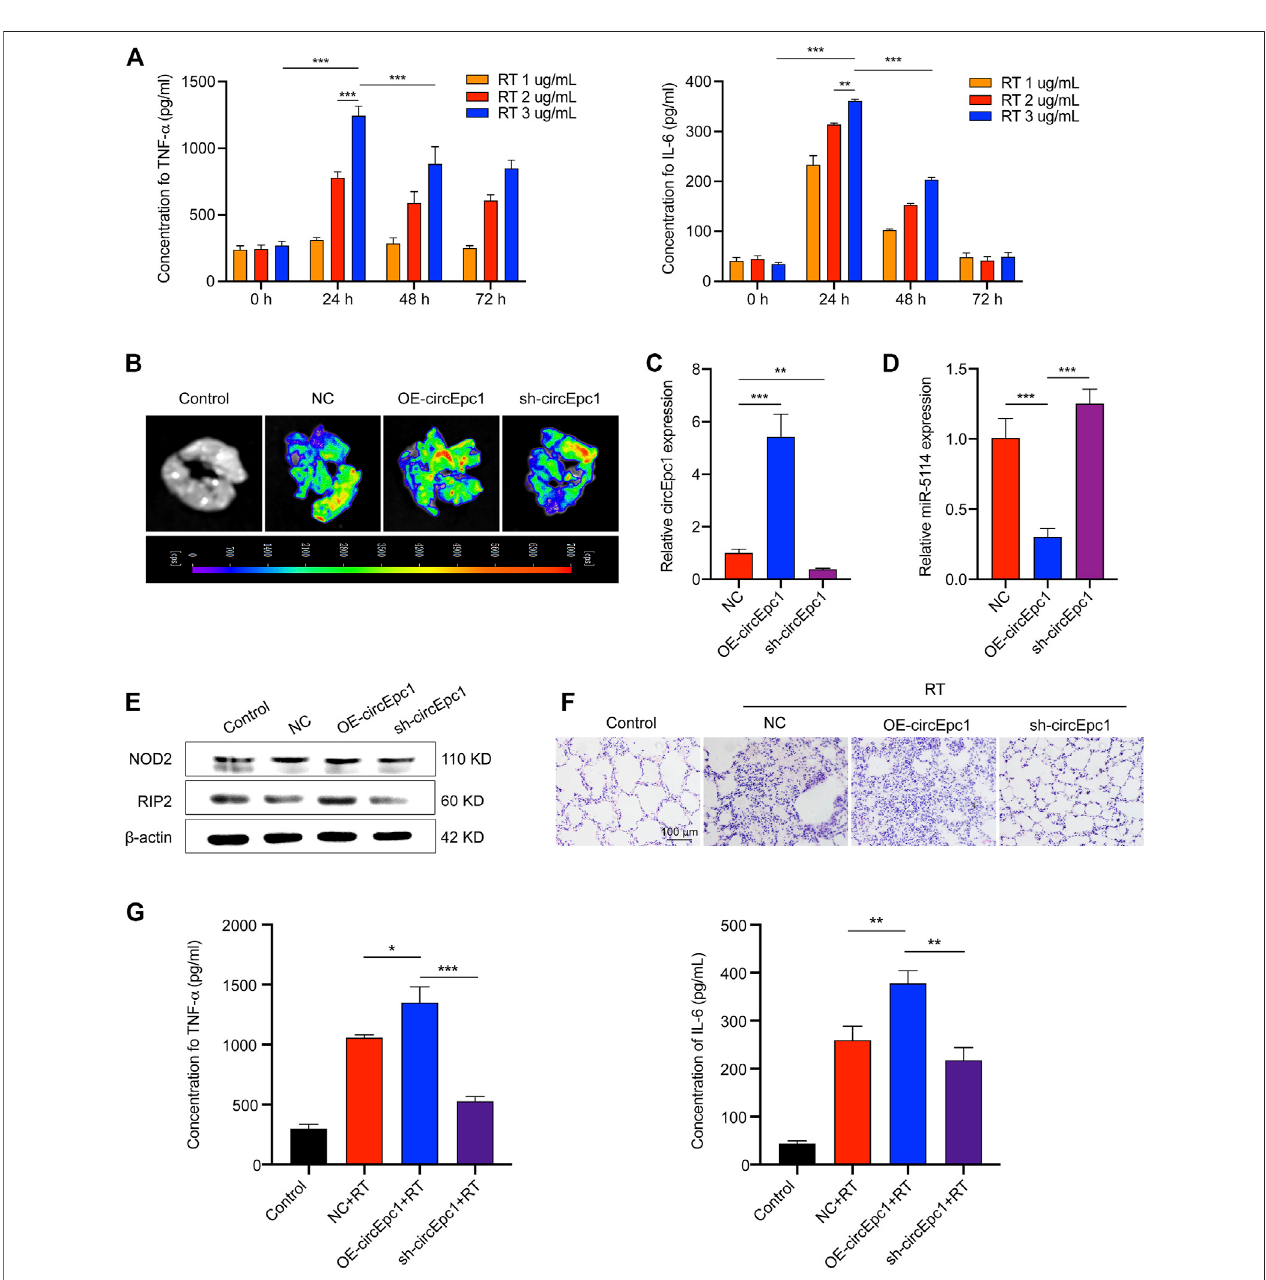
FIGURE6| CircEpc1promotesRT-inducedin fl ammation invivo .( A) EffectsofRTconcentrationandexposuretimeonTNF- α andIL-6secretioninmice.( B) Exvivo fl uorescence imaging of lung tissue in control and AAVs transfected mice groups. ( C, D) qRT-PCR assays were used to determine the expression of circEpc1 and miR- 5114inAAVstransfectedmice.( E) WesternBlot assayswereused todeterminetheproteinexpression levelofNOD2andRIP2inAAVs transfected mice.( F) Theimage (H&Estaining)ofmouselungmorphologicalchangesandin fl ammatorycellin fi ltrationincontrolandRTexposedgroupsofAAVstransfectionmodelmice(scalebar: 100 μ m).( G) CircEpc1promotes thesecretion ofTNFand IL-6 inmice exposedtoRT.Datarepresentthemean ± SD from threerepresentative experiments (* p < 0.05, ** p < 0.01, *** p < 0.001).